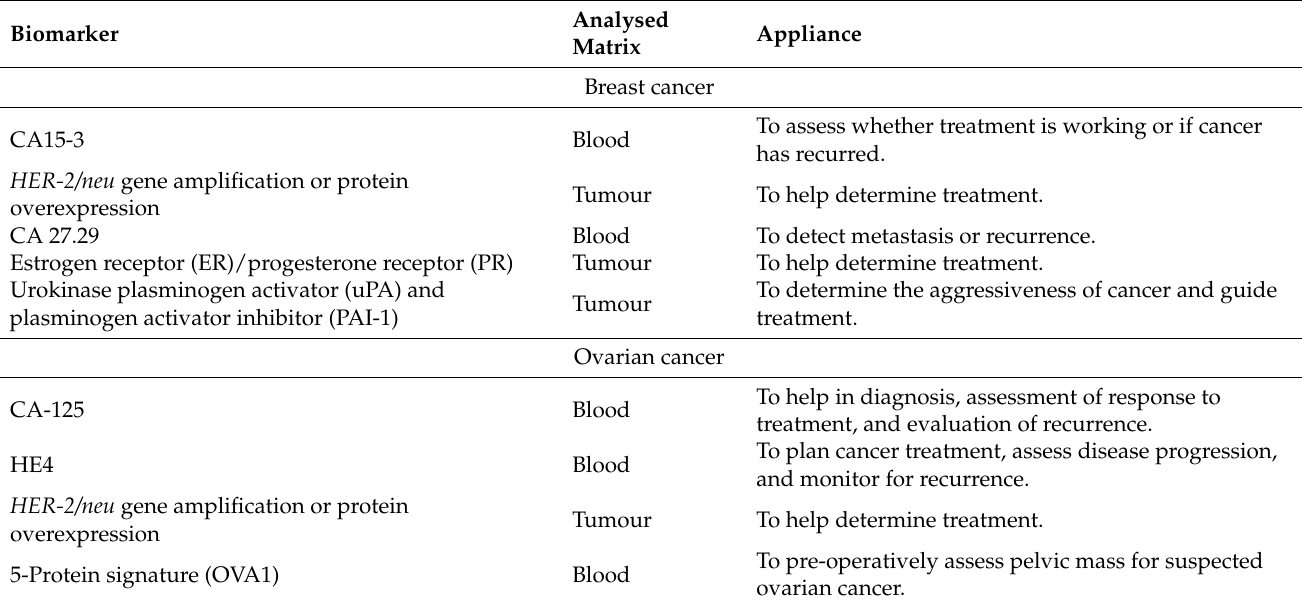
Table 1. The summary of commonly used protein biomarkers for tumour diagnosis and